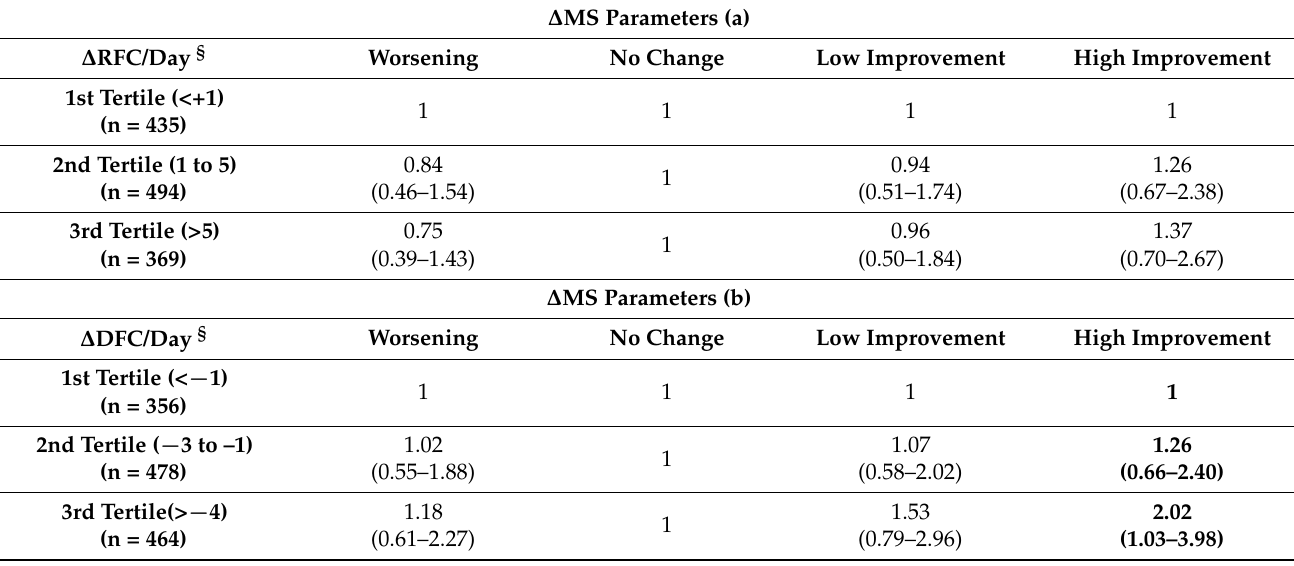
Table 3. Adjusted ORs* (95% CIs) of changes in ∆ MS parameters according to the ∆ of Recommended Food Consumption (a) and Discouraged Food Consumption (b) after 1 year of dietary